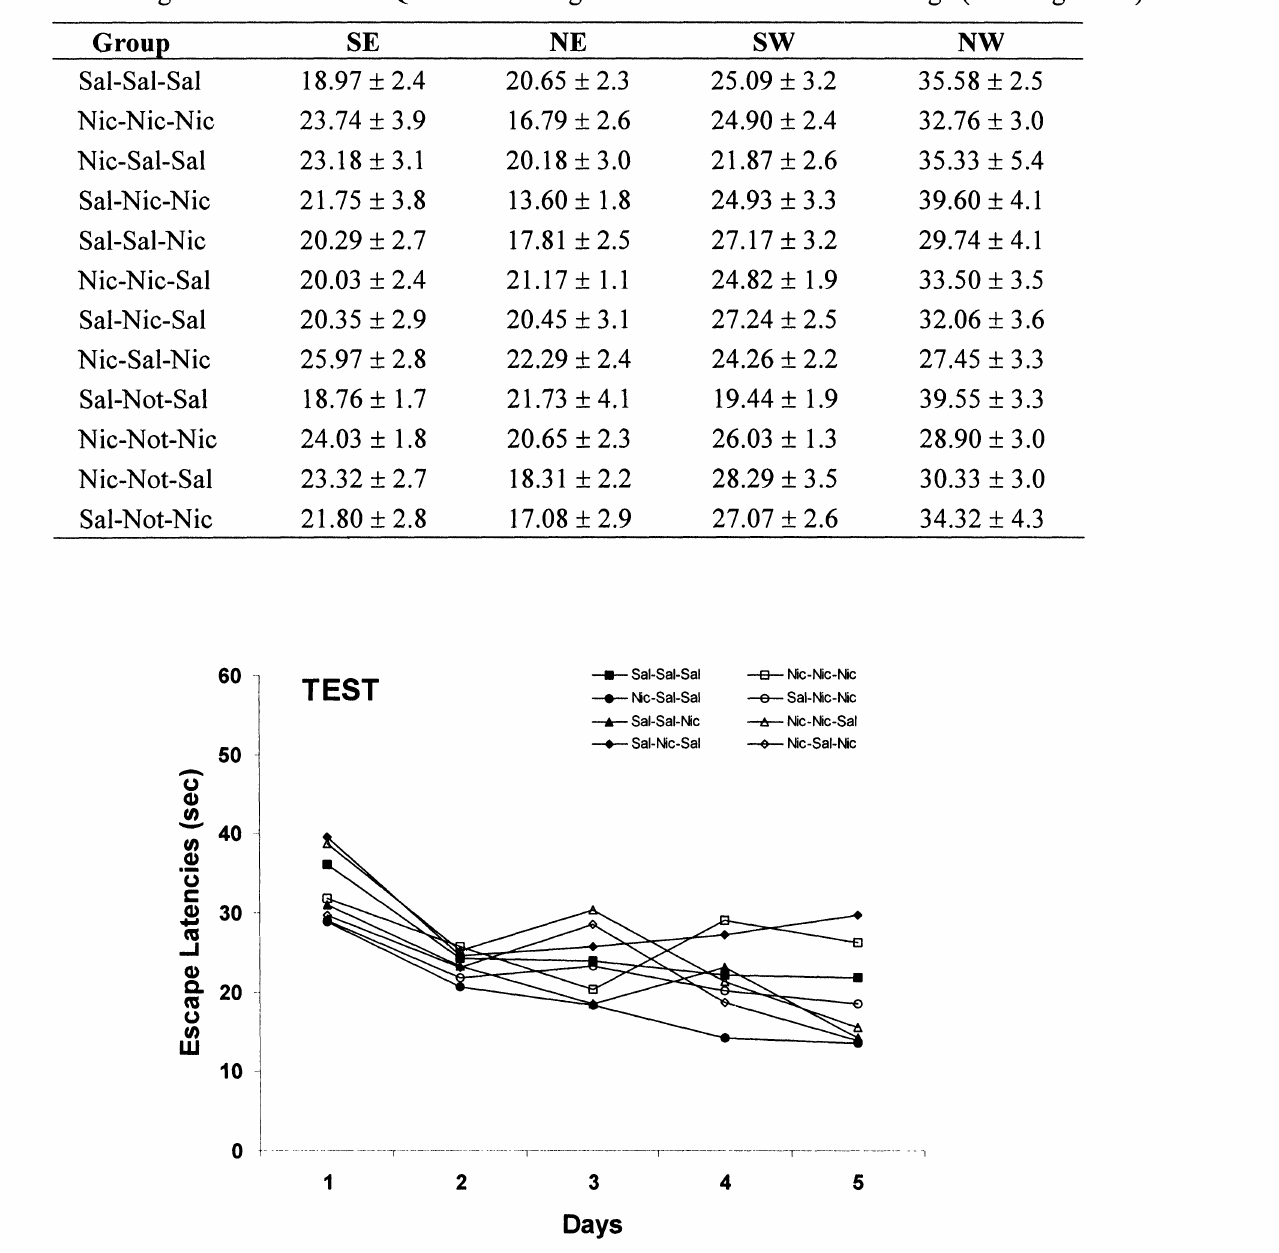
Days Mean (+ SEM) daily escape latencies (averaged over four trials/day) of NMRI mice at 6 months of age (test phase). In this Fig. 2: phase, mice assigned to 8 experimental groups were evaluated. Each group is named according to the drug treatment in each phase of the longitudinal study: nicotine (Ni), physiological saline (Sal) and no drug treatment or behavioral manipulation (Not). In this test phase, 4 groups received saline and 4 groups received nicotine, as indicated with the second abbreviation used for the legend of each